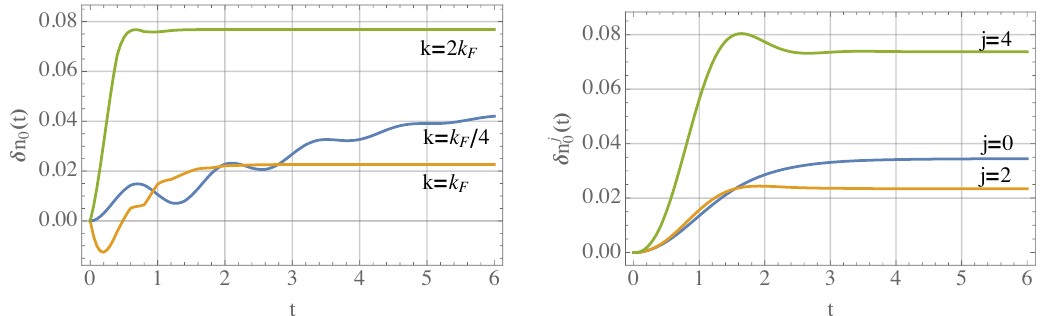
Figure 12: Left panel: The dynamics of the k = 0 mode following an initial state (31) with ε = 1 and three different values of the momentum k . Right panel: The dynam- ics of the k = 0 mode following an initial Gaussian state of (34). Additionally to the density moments ( j = 0), we plot the the second and fourth moments. In comput- ing the time evolution we took into account only the smallest momentum modes of δ n ( θ , t , x ) k